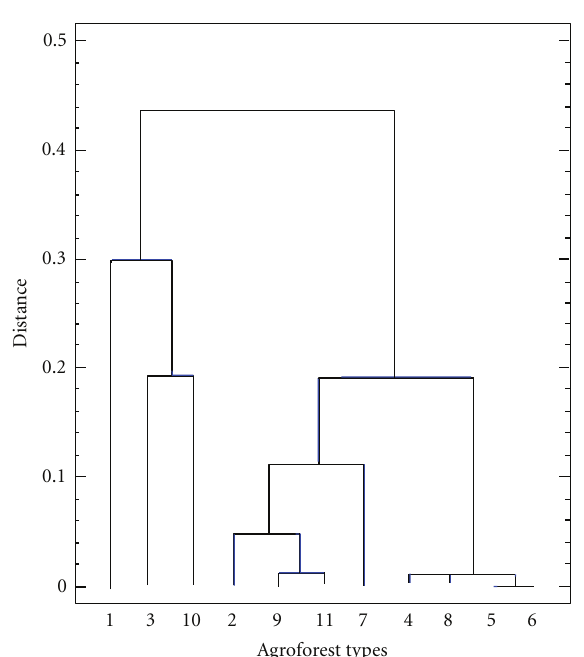
Figure 1: Hierarchical classification showing 11 types of agroforests existing in the tropical Guinean Highland savannahs